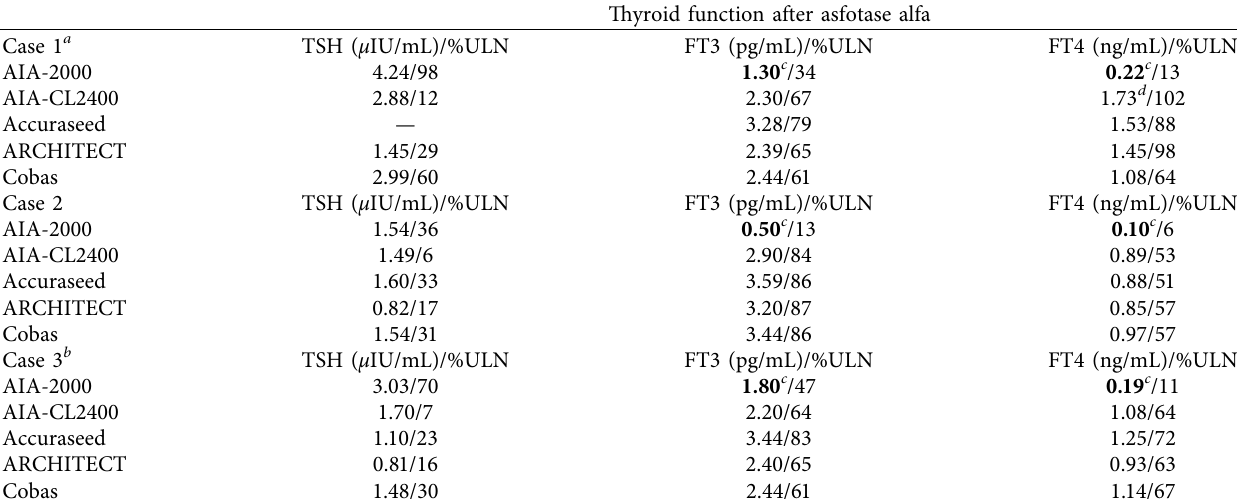
Table 2: Thyroid function in three cases assayed by different analyzers before and after asfotase alfa treatment.